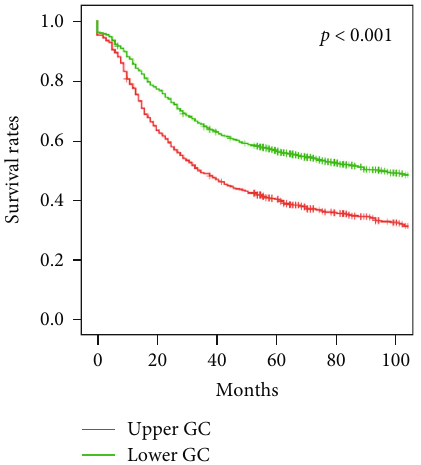
Figure 1: Survival of patients with upper and lower gastric cancers, p < 0 : 001 . Abbreviations: GC: gastric